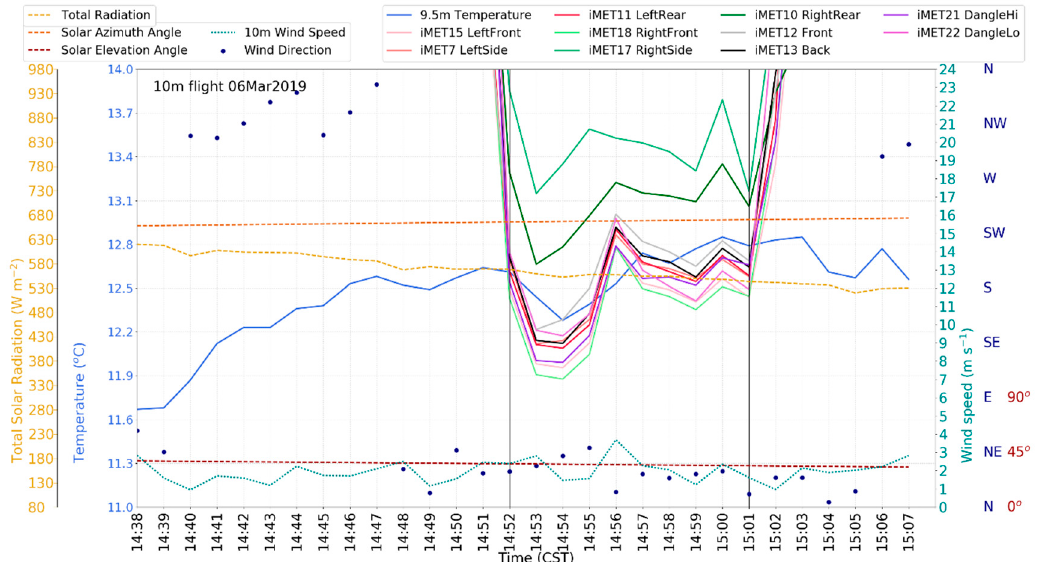
Figure 12. Time series from the 6 March 2019 of the tower temperature at 9.5 m ( ◦ C, solid blue), iMET-XQ temperatures ( ◦ C, various solid colors as shown in the legend), solar radiation (W m − 2 , dashed mustard yellow), solar azimuth angle (degrees, dashed orange), solar elevation angle (degrees, dashed brown), tower wind speed at 10 m (m s − 1 , dotted green), the and tower wind direction at 10 m (degrees, dark blue dots). The two vertical black lines indicate the start and end times of the 10 m